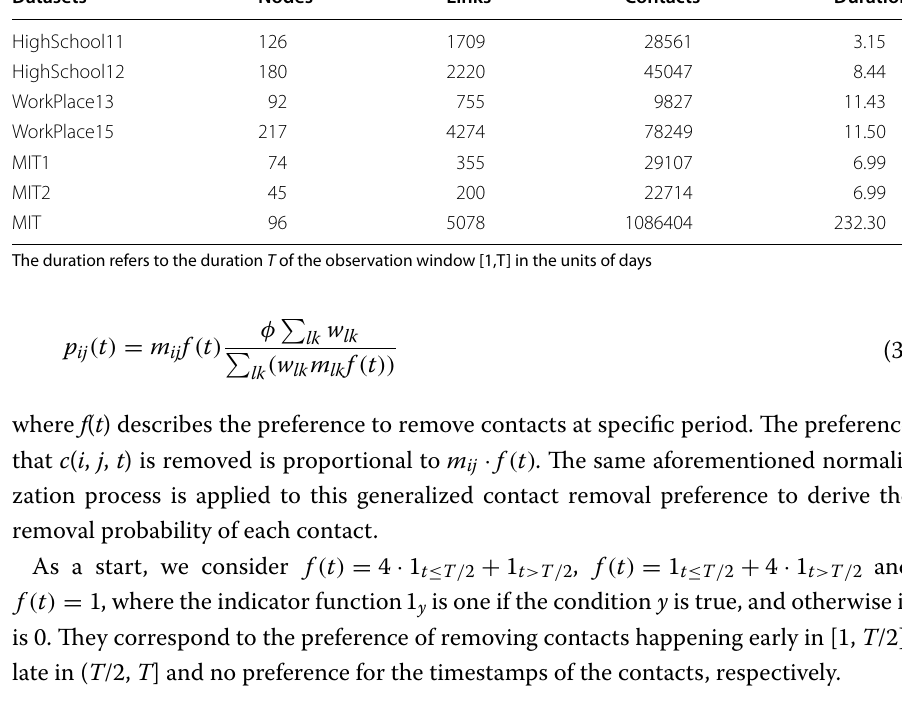
Table 1 Basic properties of real-world networks: the number of nodes, links (in the aggregated network) and contacts, respectively